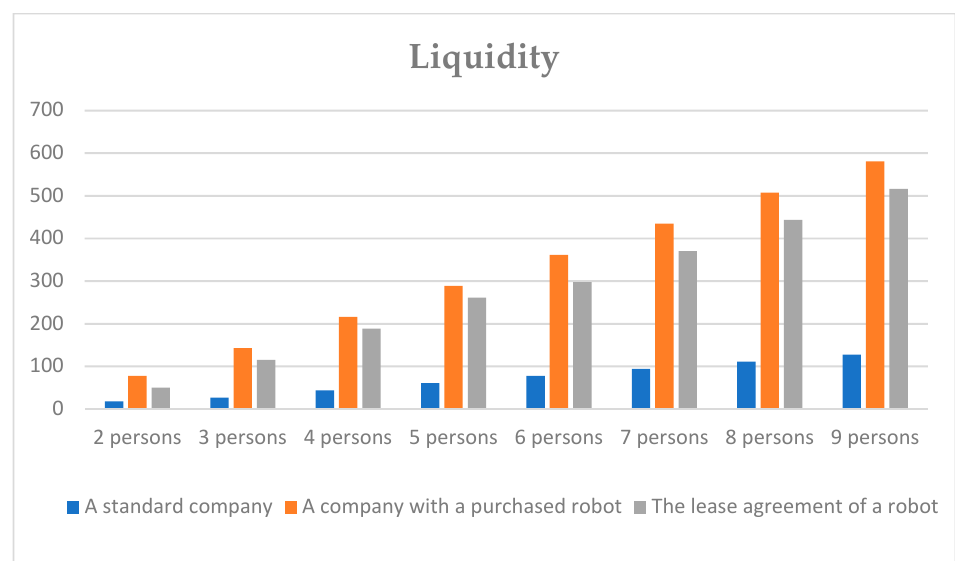
Figure 6. Financial liquidity in three varieties for business entities employing between 2 and 9 people (PLN thousand). The taxes do not include the tax on robotification.